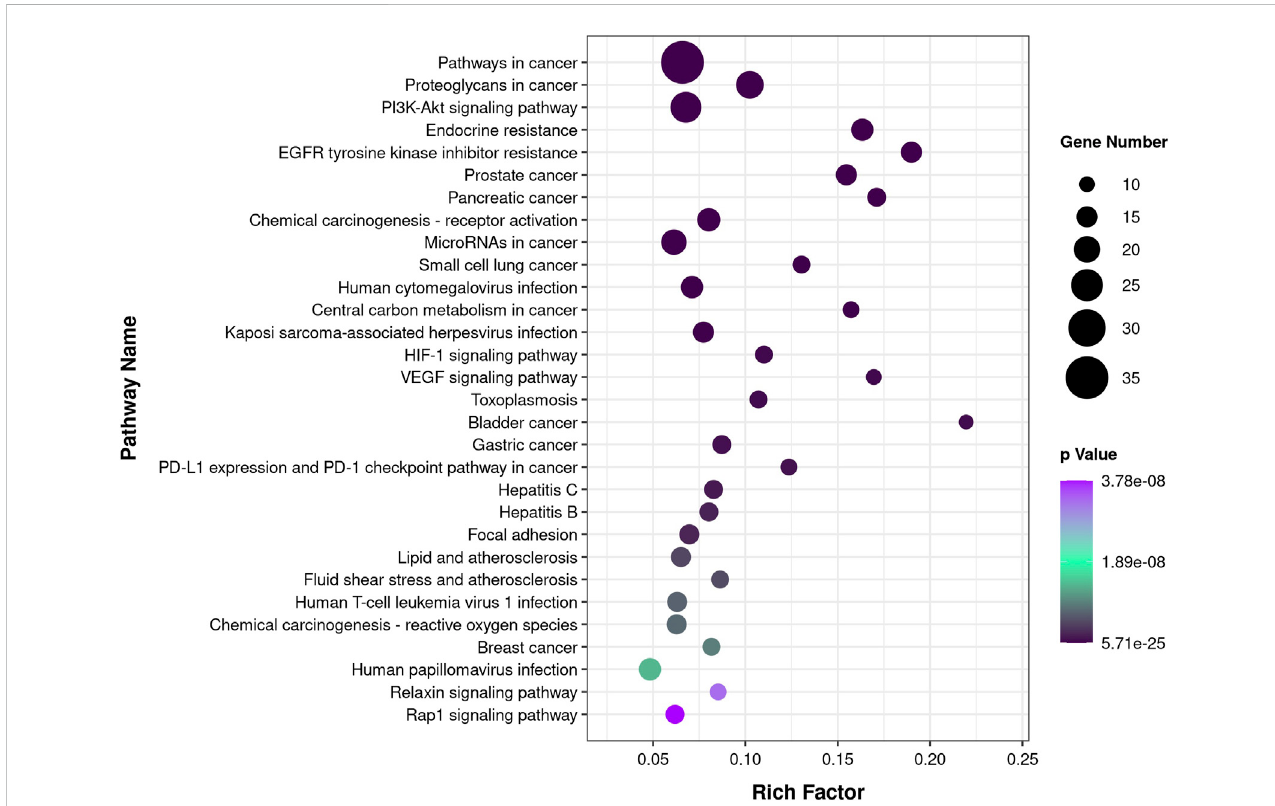
FIGURE 3 KEGG pathway enrichment analysis. The color of the circles is displayed in a gradient from purple to black according to the adjusted p -value for each KEGG pathway, with black indicating a more signi fi cant p -value. The size of the circles corresponds to the number of genes affected in KEGG each pathway.